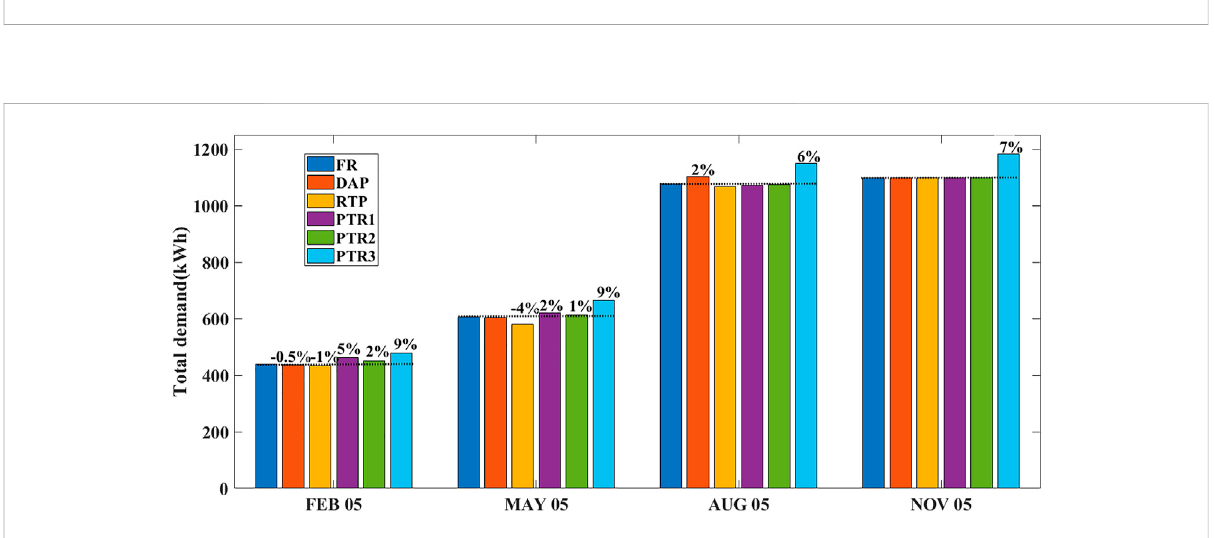
FIGURE 11 Percentage change in total demand for all seasons and all pricing